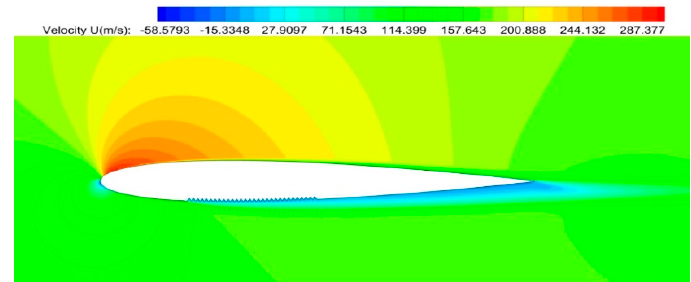
Figure 14. 4° angle of attack, speed distribution of grooves on the pressure side.